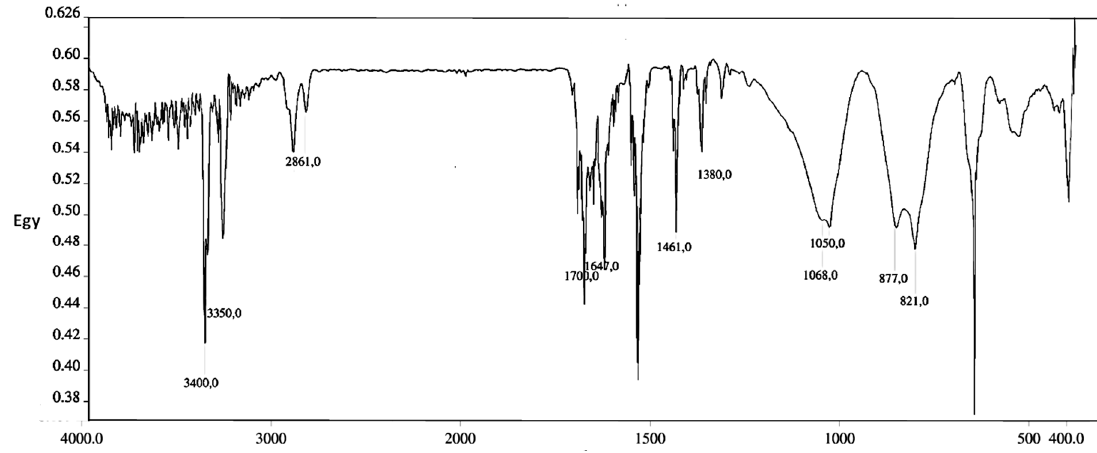
Figure 2. FT IR spectra mixing spectroscopic grade KBr of PEI-MWCNTs ( 4